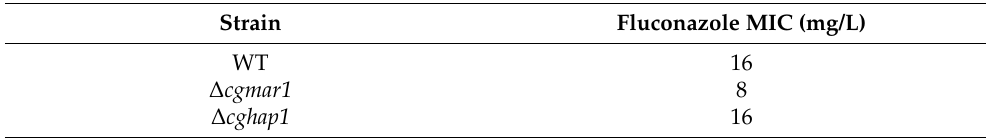
Table 2. Fluconazole susceptibility profiles determined by MIC values in deletion mutants for CgMAR1 and CgHAP1 and the corresponding parental strain